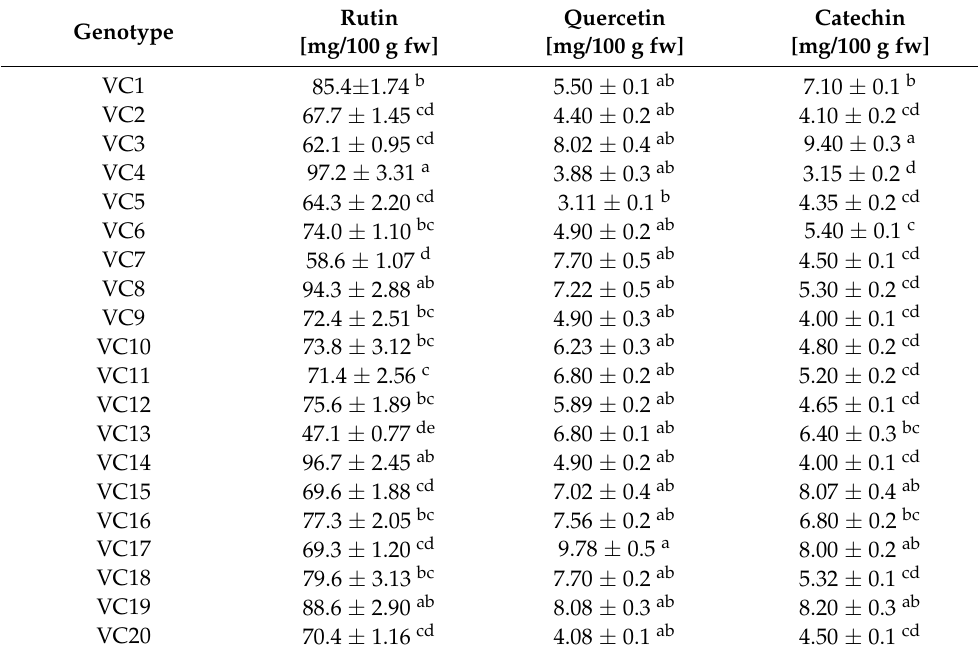
Table 3. Content of flavonoids in fruits of M. nigra genotypes.